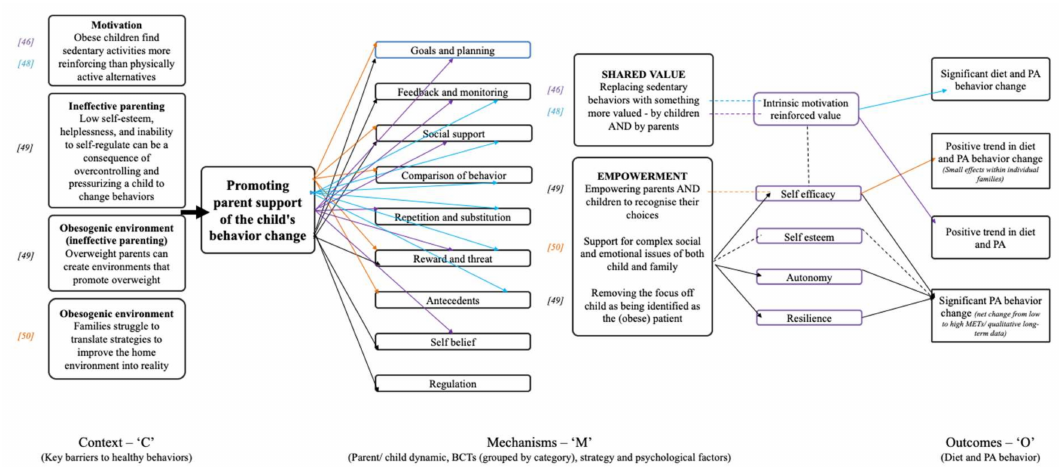
Figure 5. C-M-O pattern based on interventions promoting parent support of the child’s behavior change. Solid arrows indicate configuration between context, mechanisms and outcomes evidenced by the included studies, and dashed arrows depict those configurations that were hypothesized but not